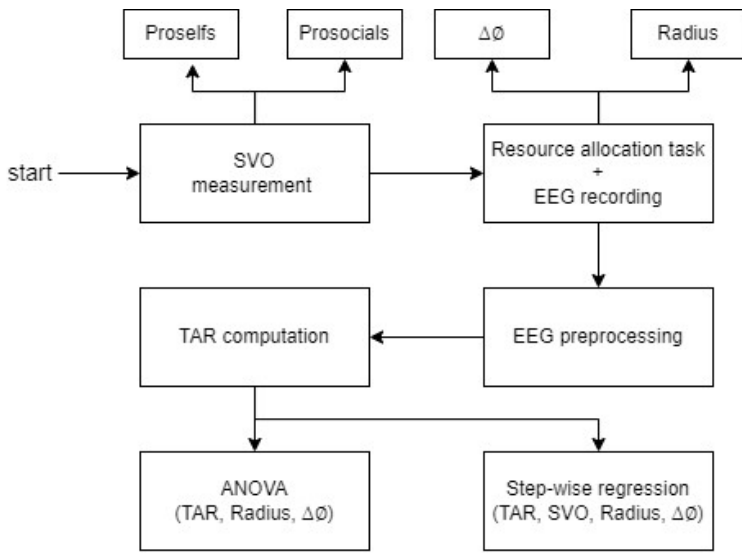
Figure 6. Summary of the experimental design stages.